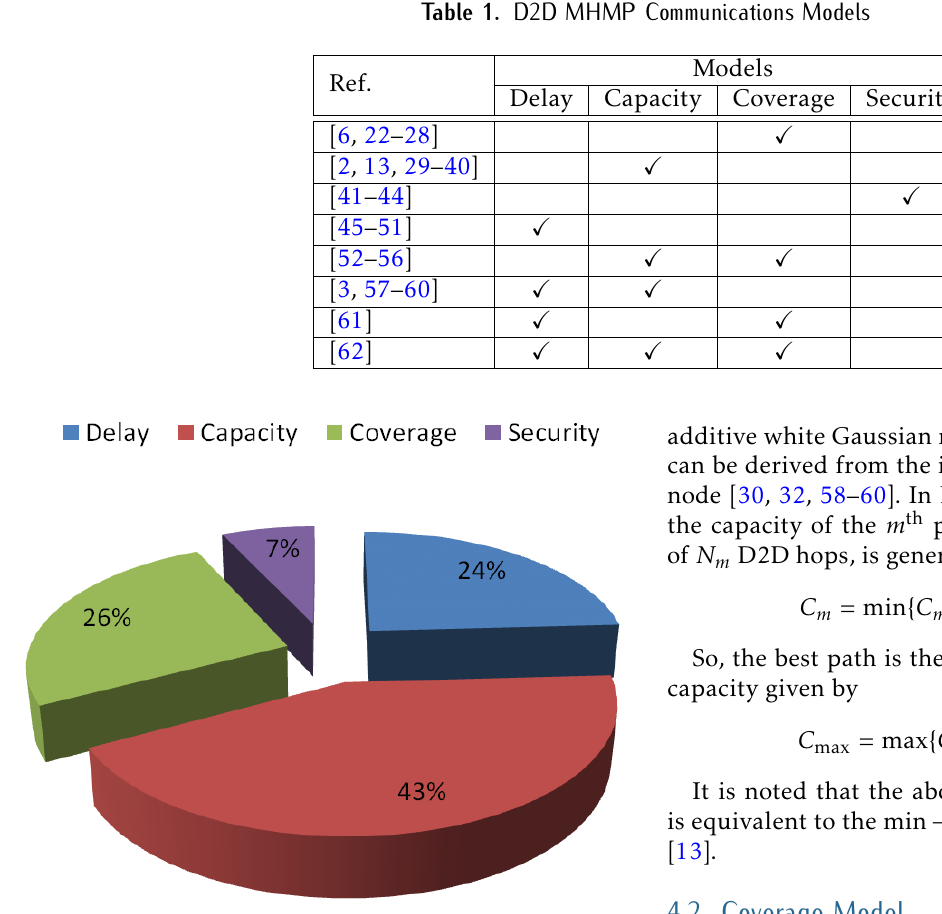
Figure 3. Key models of D2D MHMP